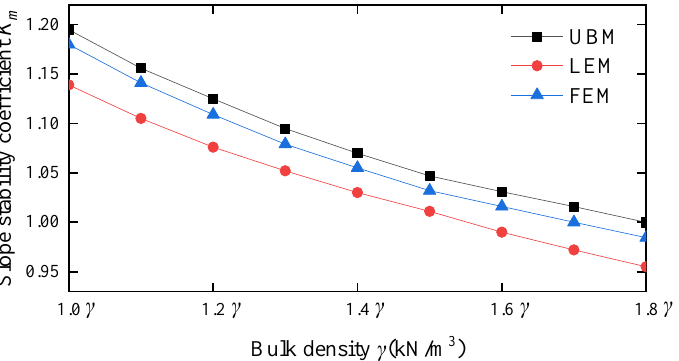
Figure 3. Relationship between external load and slope stability coefficient of homogeneous slope.